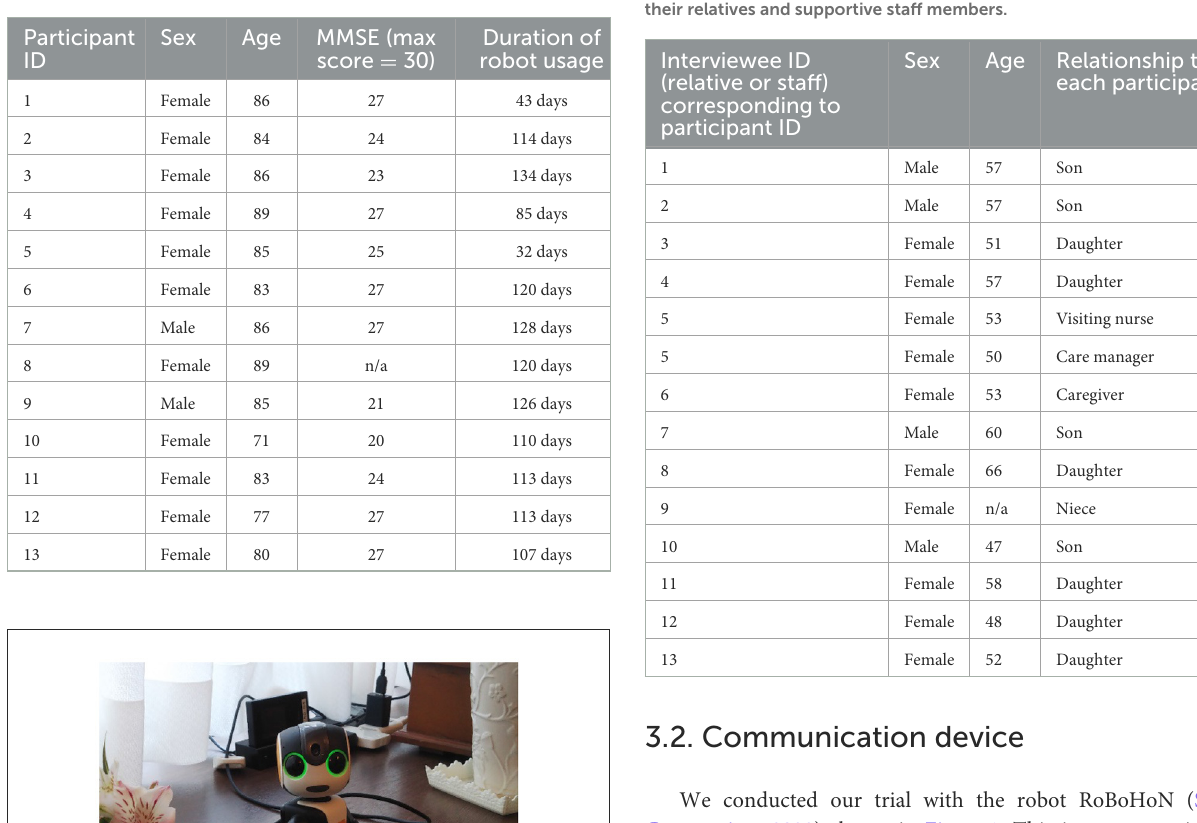
TABLE 1 Participants’ profiles and duration of their robot usage.